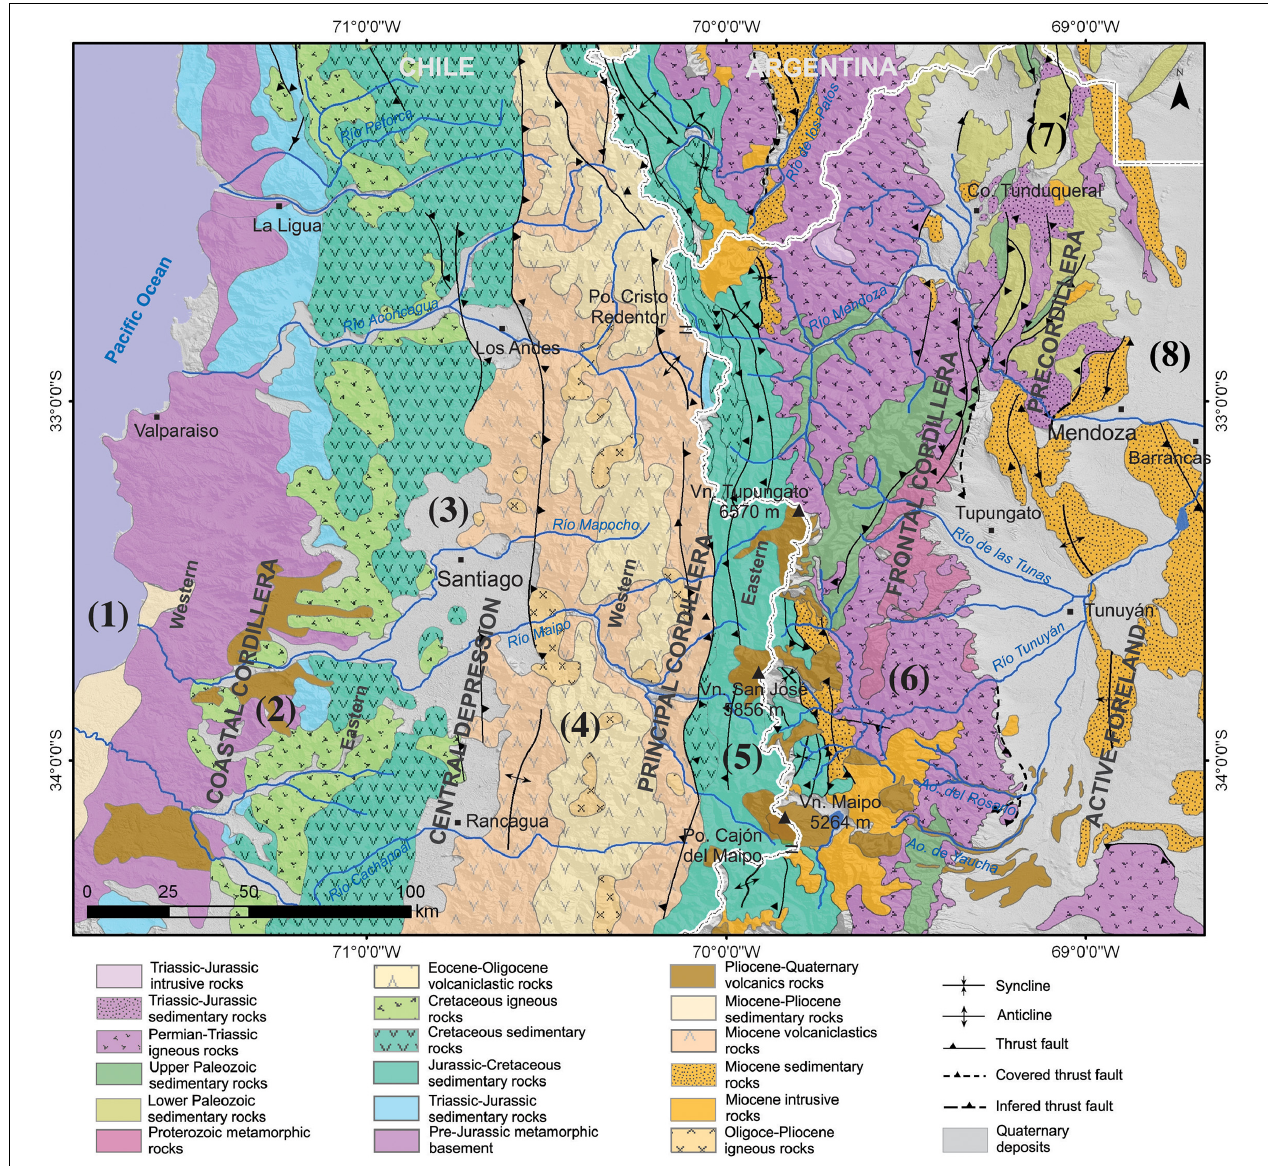
FIGURE 2 | Main morpho-structural units of the southern Andes between 32 ◦ and 34 ◦ S in Argentina and Chile (modified from Barberena et al., 2017). Key : (1) Pacific Ocean; (2) Coastal Cordillera; (3) Central Depression-Central Chilean Valley; (4) Western Principal Cordillera; (5) Eastern Principal Cordillera; (6) Frontal Cordillera; (7) Precordillera; and (8) Active